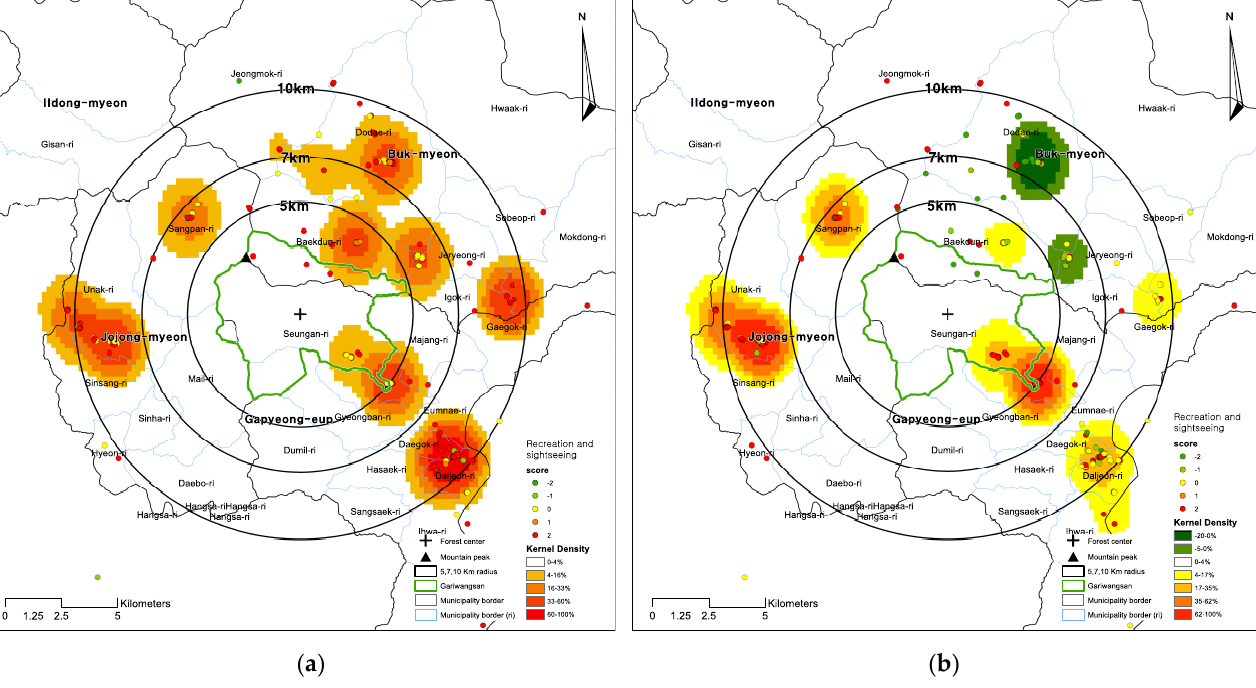
Figure 10. Kernel density maps of ( a ) recreation and sightseeing and ( b ) forest products demand in Yeoninsan.